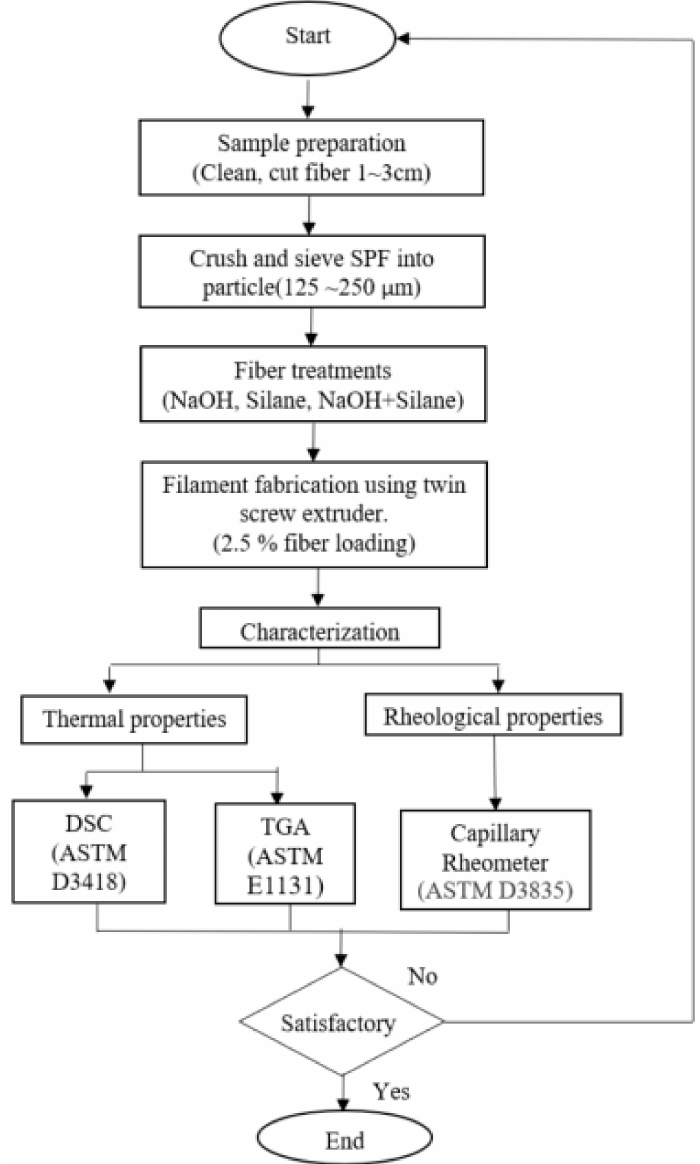
Figure 3. Flowchart of process